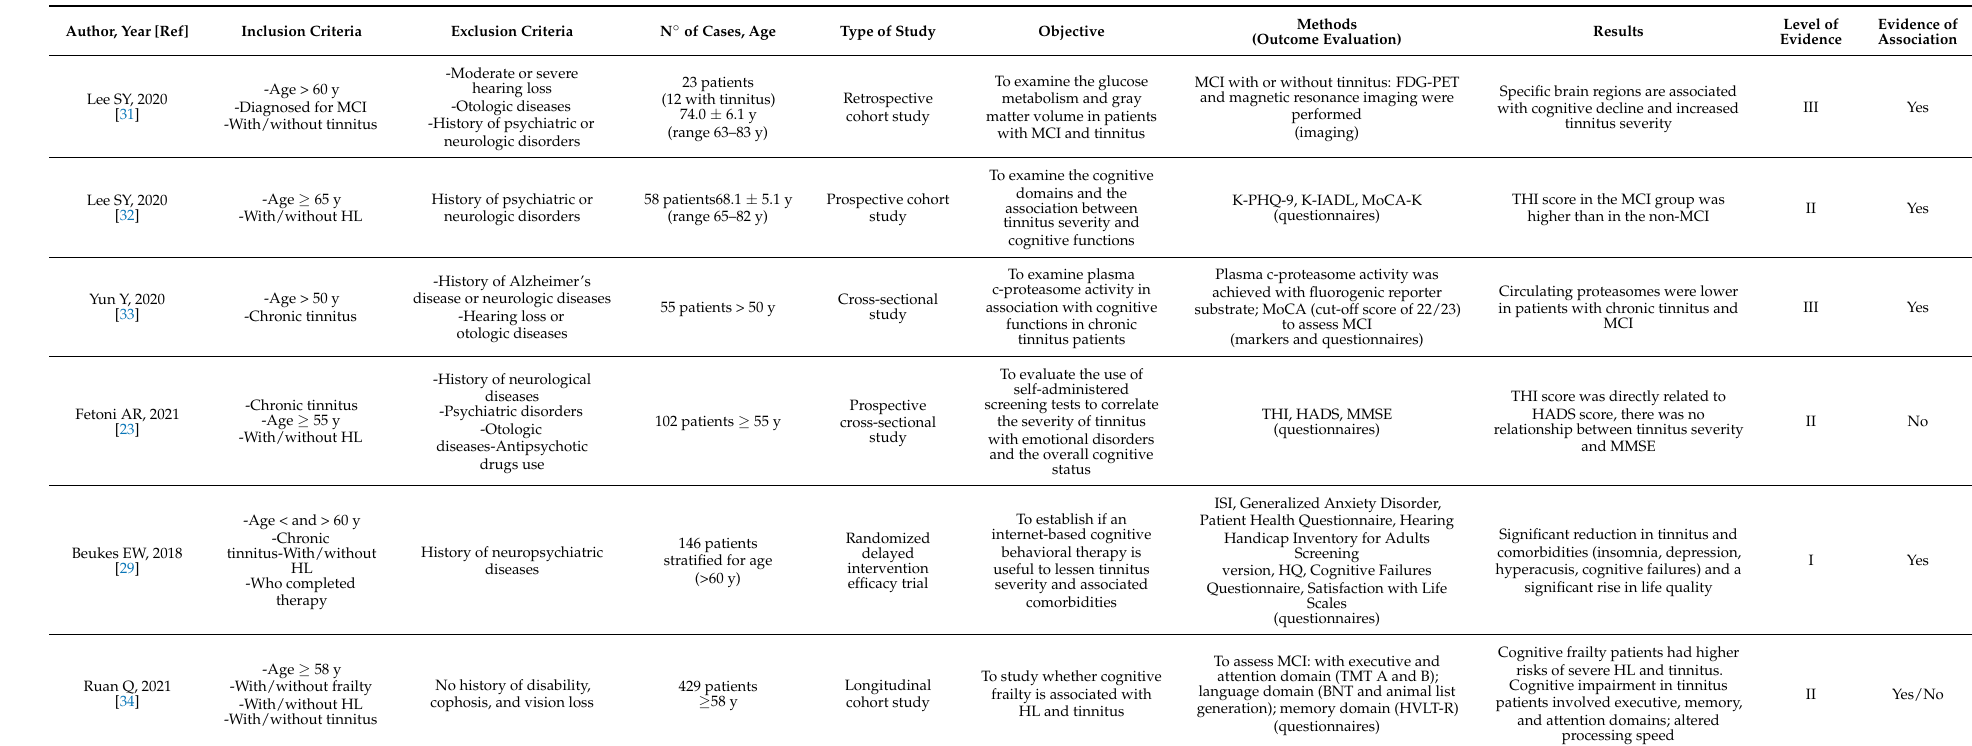
Table 2. Evidence linking chronic tinnitus to cognitive decline in the